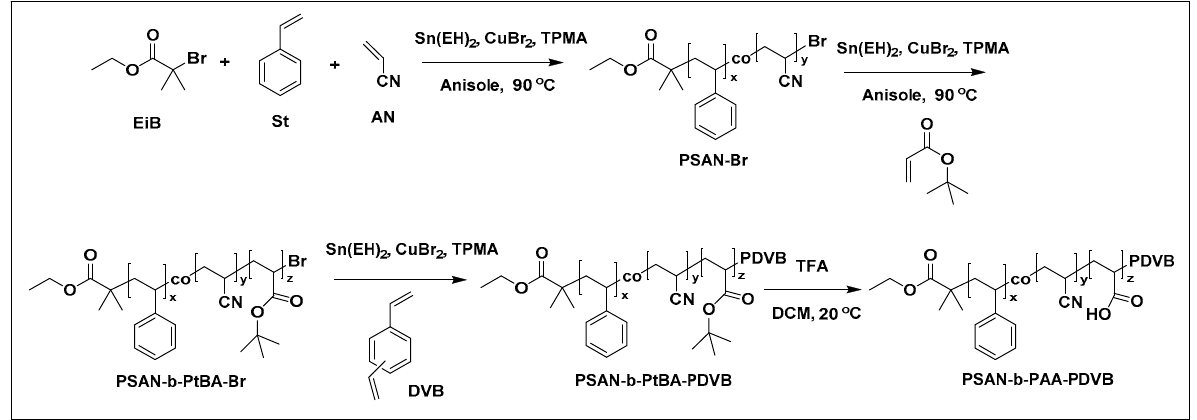
Figure 21. Synthesis of PSAN- b -PAA-PDVB star-shaped polymer templates. Reproduced with permission from Ref [252]. Guo et al. synthesized PS-grafted BaTiO 3 nanoparticles with sizes of 11 nm and 27